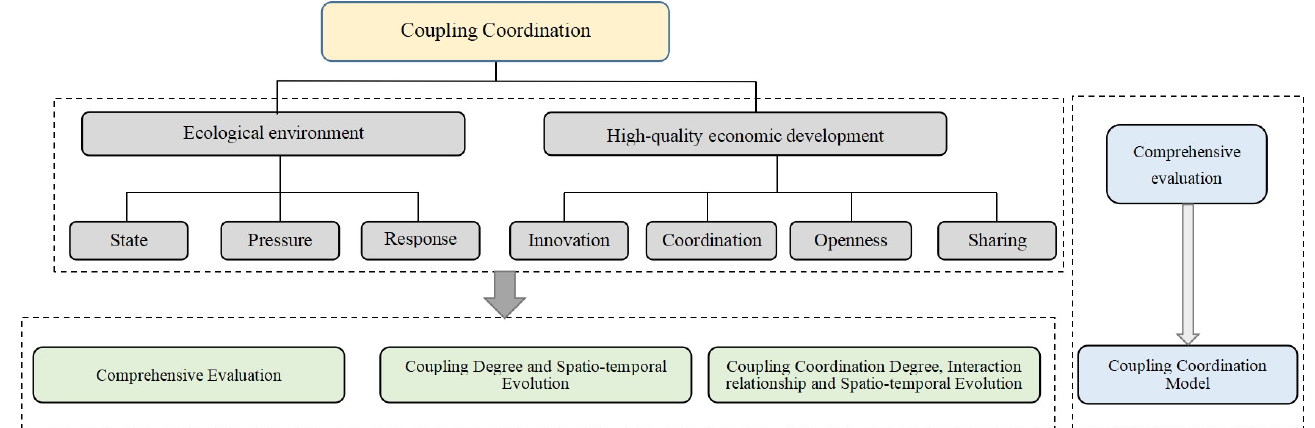
Figure 1. Research design.